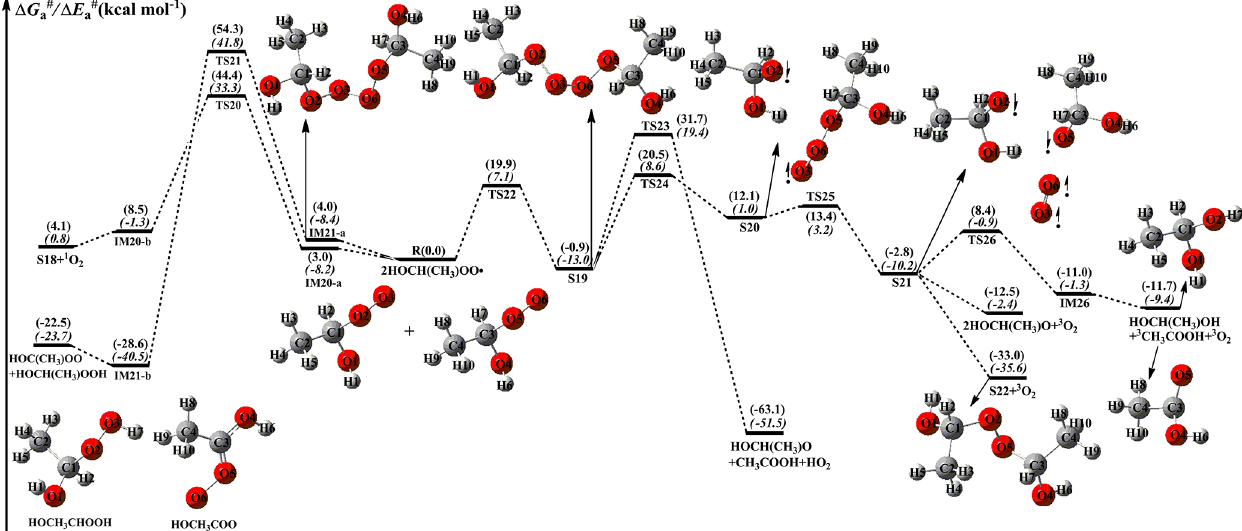
Figure 6. PES ( (cid:49)G # a and (cid:49)E # a , in italics) for the self-reaction of HOCH(CH 3 )OO radicals predicted at the M06-2X/ma-TZVP//M06-2X/6- 311+G(2df,2p) level of theory.